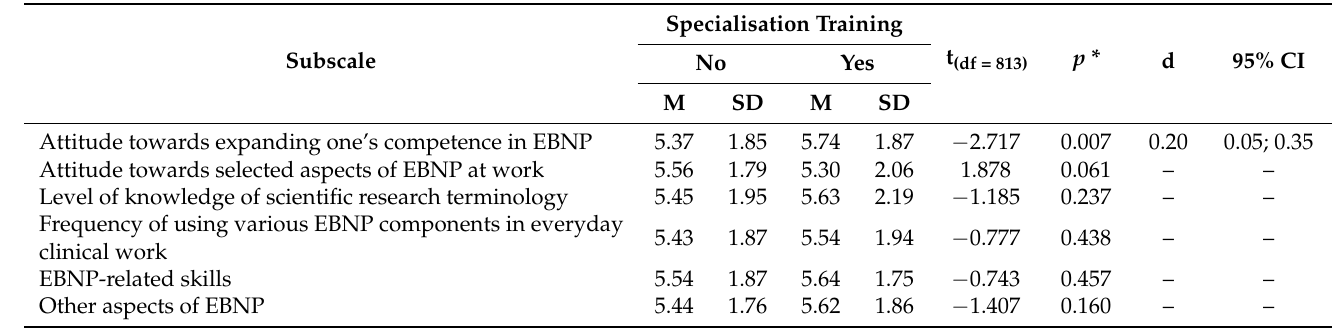
Table 7. Impact of the respondents’ nursing specialisation on the knowledge of, attitudes toward, and skills in EBNP according to the EBPPQ.